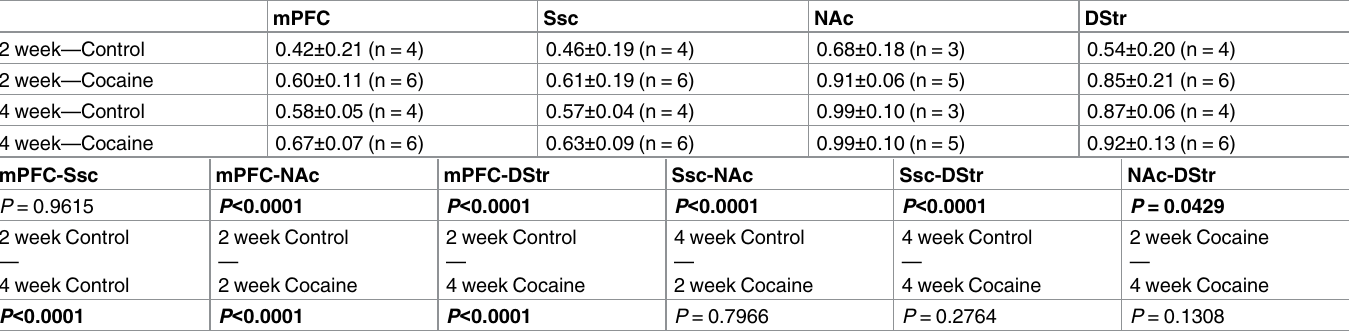
Table 1. NOS1 expression (mean ± Std) in different brain regions including mPFC, Ssc, NAc and DStr, following cocaine treatment for 2 weeks and 4 weeks. P values calculatedusing two-way ANOVA (SAS) are listed below. Significant P values ( P < 0.05)are bolded.